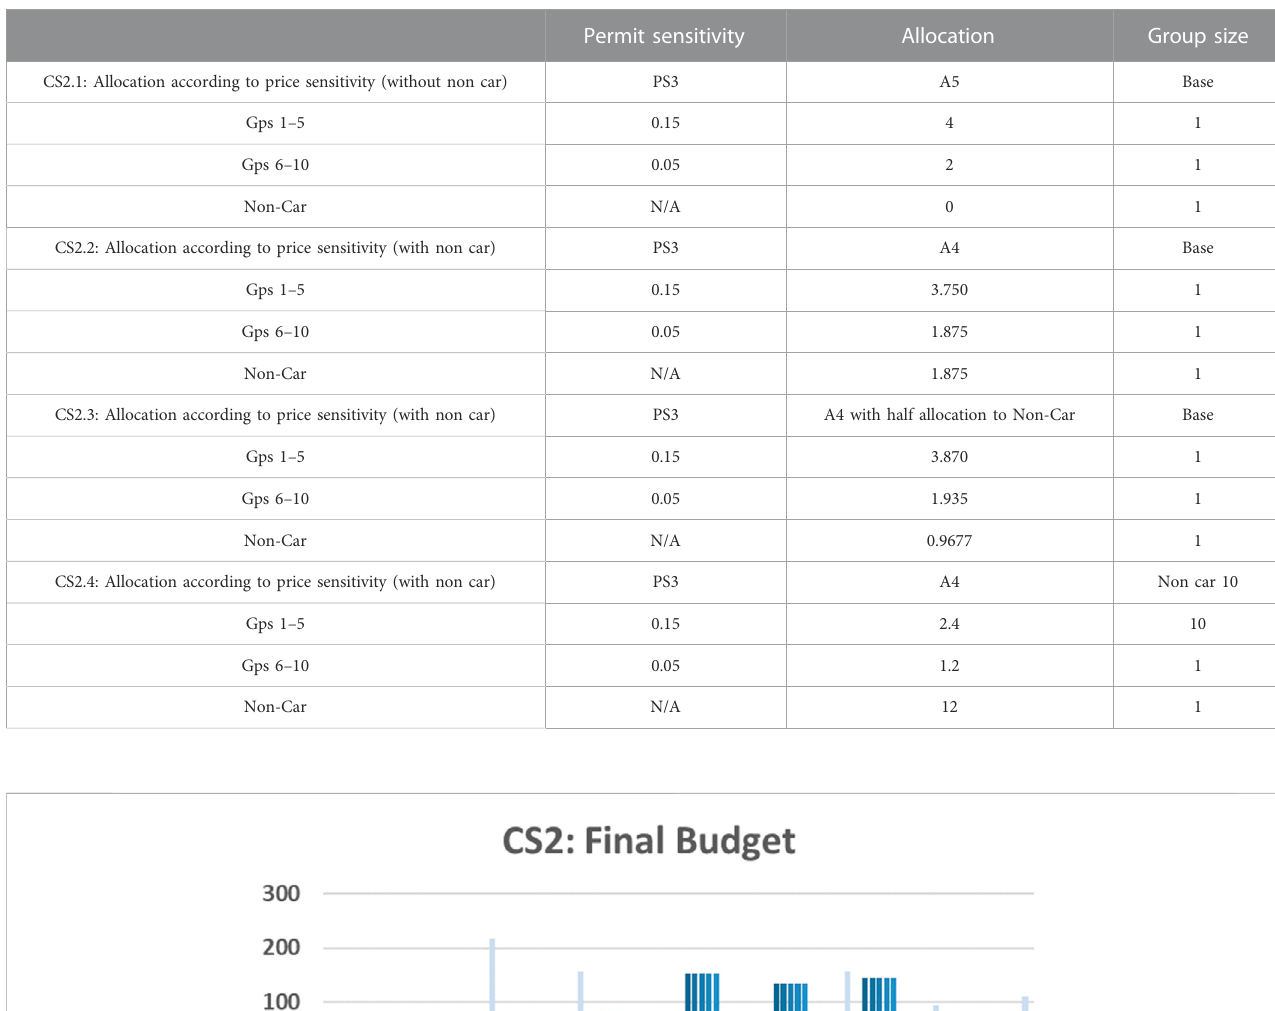
Permit sensitivity Allocation